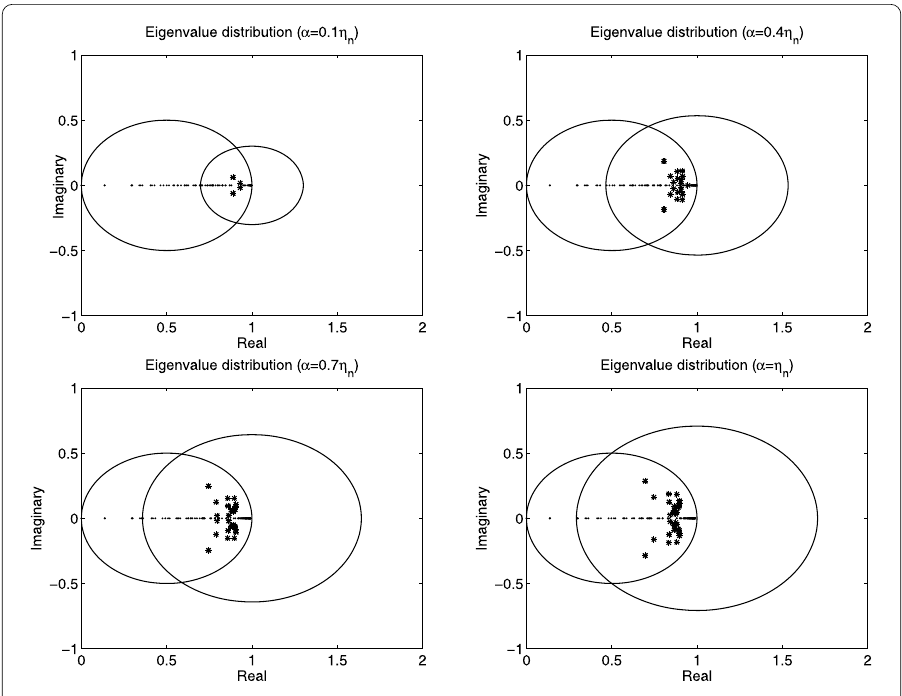
A for Example 3.2. SS